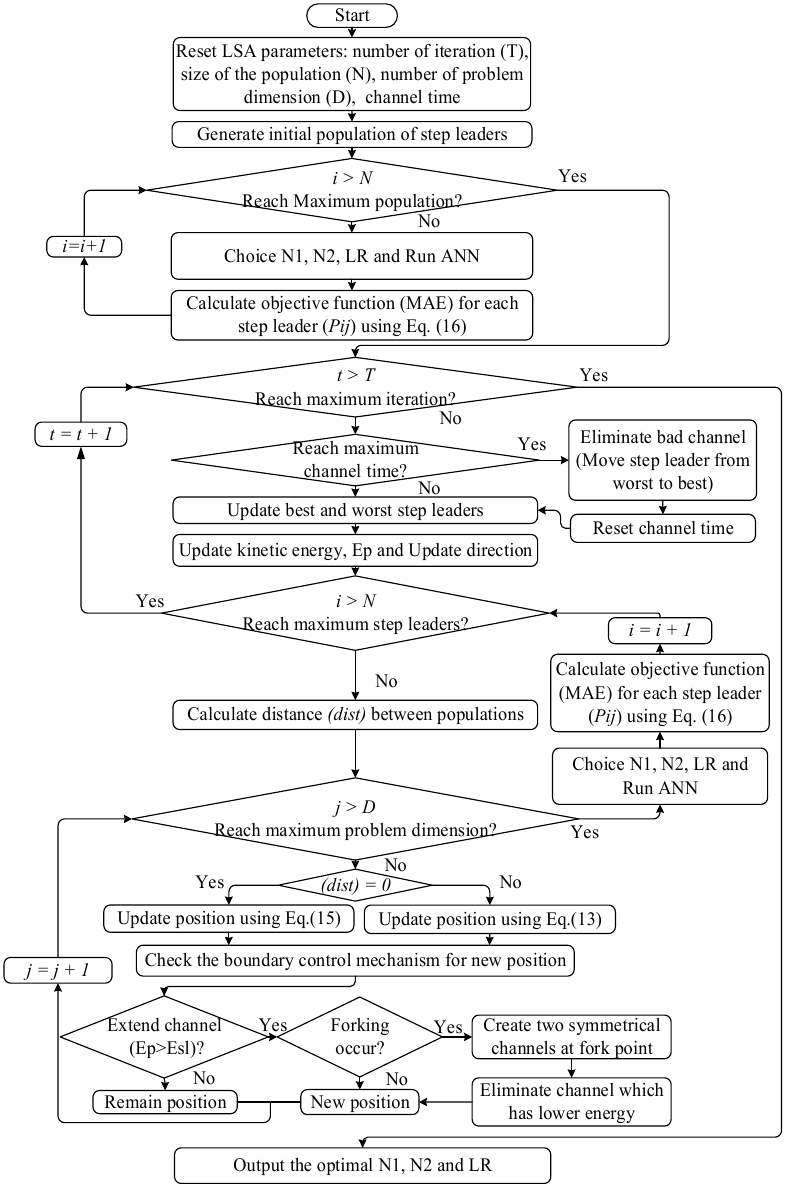
Figure 14. Flowchart of the proposed hybrid LSA ‐ ANN.